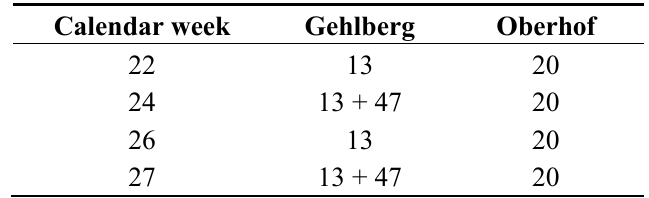
Table 1. Number of drone colonies at mating apiaries Gehlberg and Oberhof during the experiment.